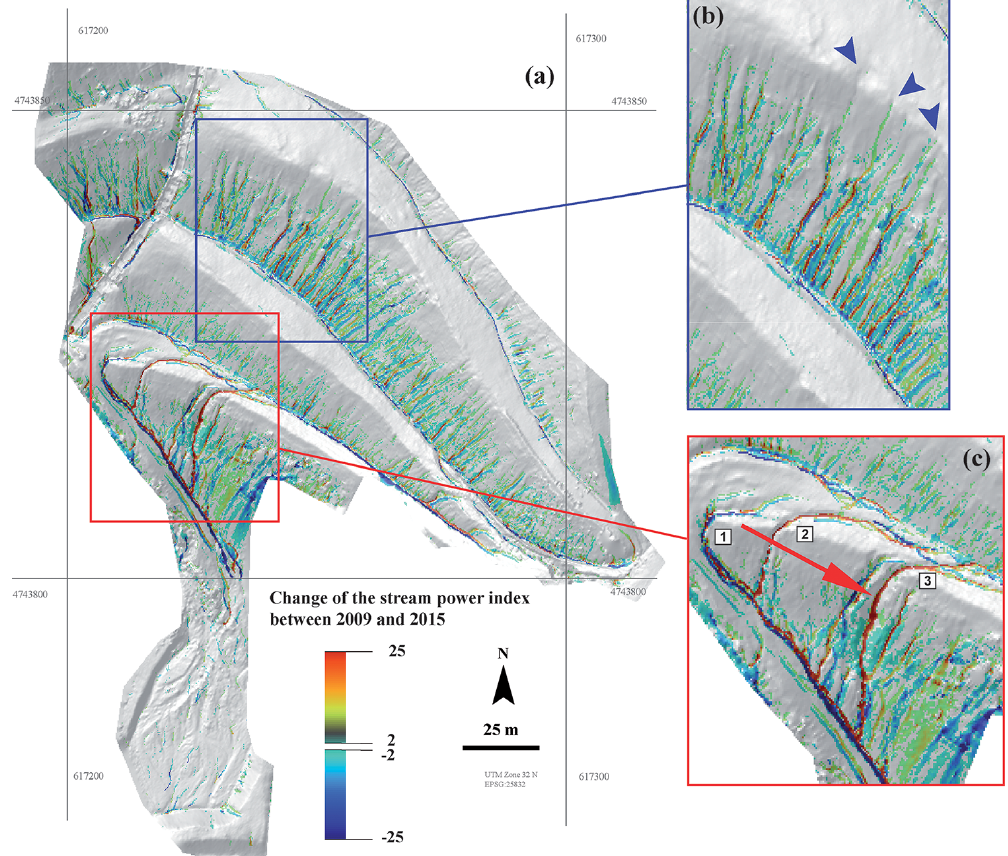
Figure 14. (a) Change of the stream power index between 2009 and 2015 for the slope (for better visualization, data from − 2 to 2 are excluded), (b) back-cutting of channels up to the top of the terrace indicated by the SPI, and (c) shifting of the main channel/gully from west to the east with increasing